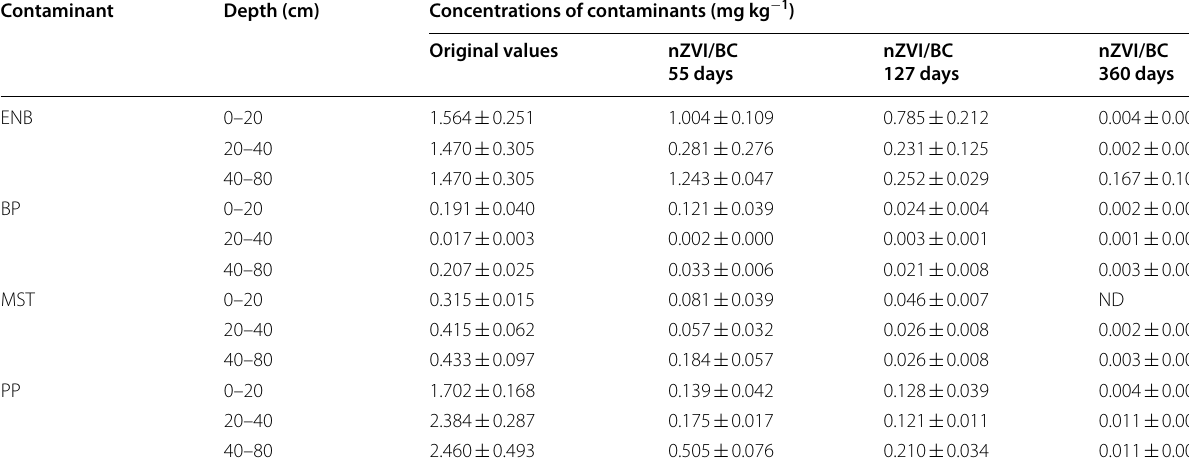
ENB: 2-Ethylnitrobenzene; BP: Biphenyl; MST: 4-(Methylsulfonyl) toluene; PP: 4-Phenylphenol